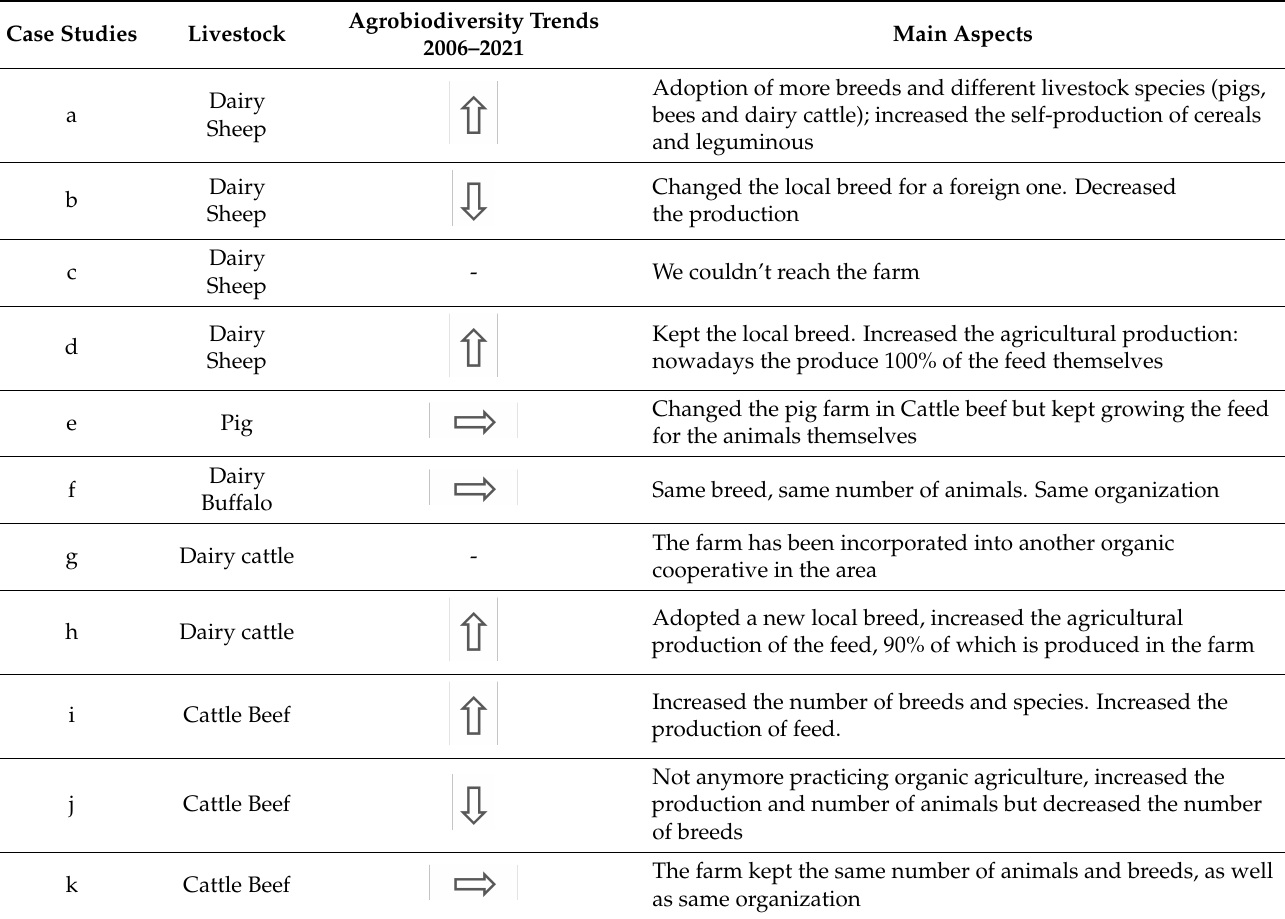
Table 5. Agrobiodiversity trends 2006–2021 of the different farms under